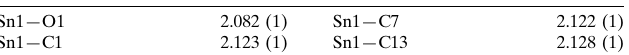
Selected bond lengths (A˚ ).